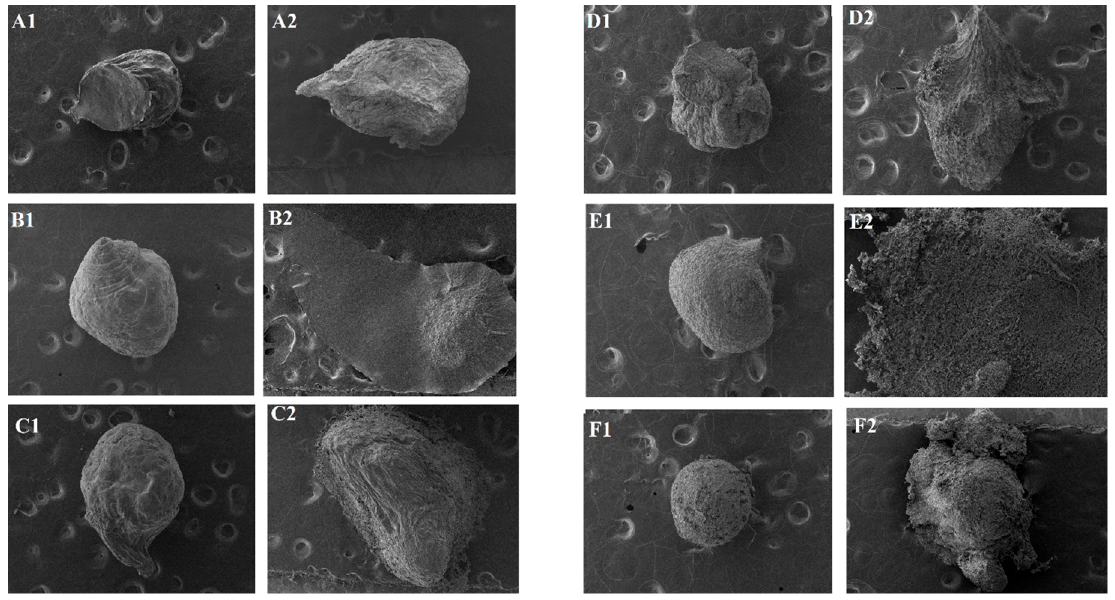
Figure 4. Photomicrographs of microparticles after enzyme degradation assay (40×)- A : GRSCa; B : GRSAl; C : GRSCaAl; D : GPCa; E : GPAl, and F : GPCaAl, 1: gastric medium and 2: enteric medium).